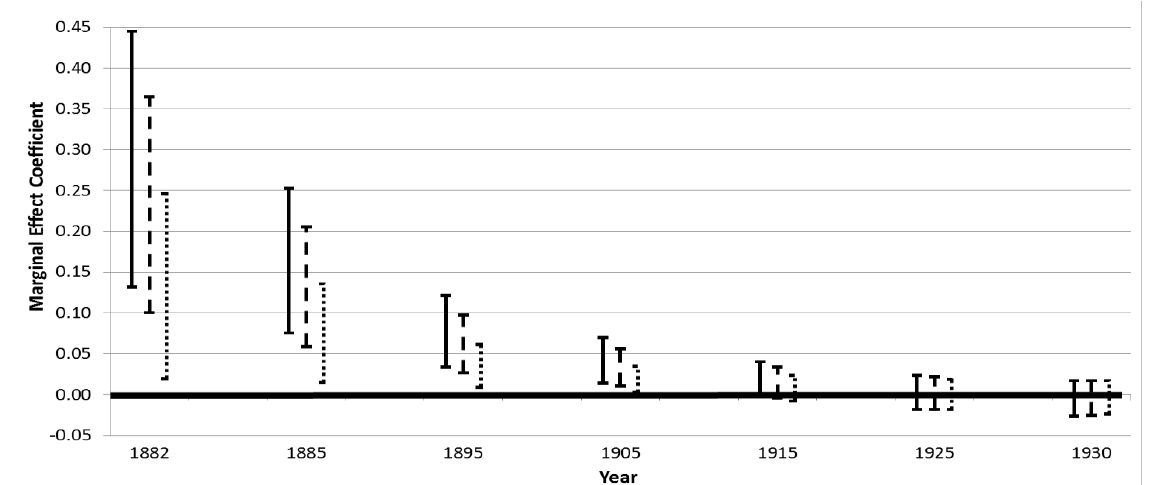
Figure 1: Marginal effect coefficient of manufacturing wages per capita at low (its 25th percentile), intermediate (its median), and high (its 75th percentile) levels in different years from 1882 to